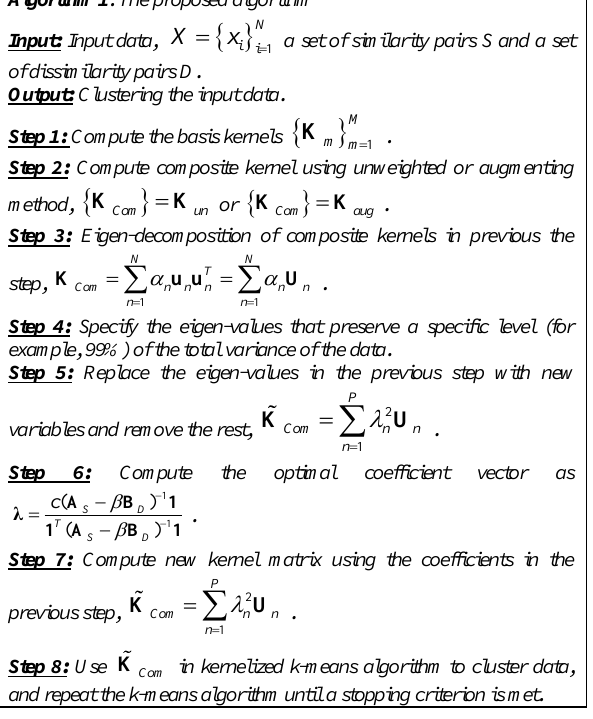
Algorithm 1 . The proposed algorithm